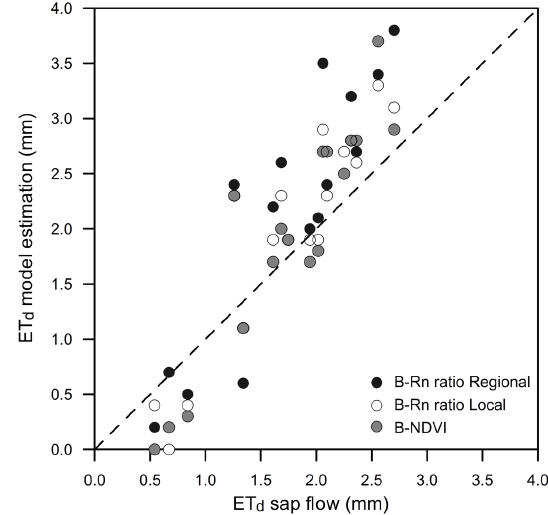
Fig. 4. Relationship between daily evapotranspiration (ET d ) cal- Figure 4. Relationship between daily evapotranspiration (ET d ) calculated from sap flow 2 culated from sap flow measurements modelled using Landsat data measurements modelled using Landsat data and the B parameter approach in mm·day -1 . 3 and the B parameter approach in mmday − 1 . B - R n ratio regional is the B approach using the regional R n ratio, B - R n ratio local is the B-R n ratio regional is the B approach using the regional R n ratio, B-R n ratio local is the 4 B approach using the local R n ratio and B-NDVI is the B approach B approach using the local R n ratio and B-NDVI is the B approach using the NDVI. 5 using the